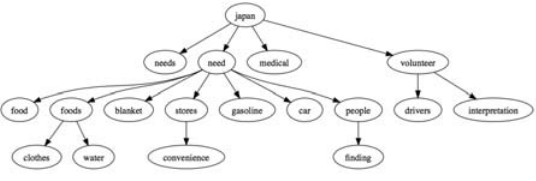
Figure 3. A concept hierarchy of keyword “need”